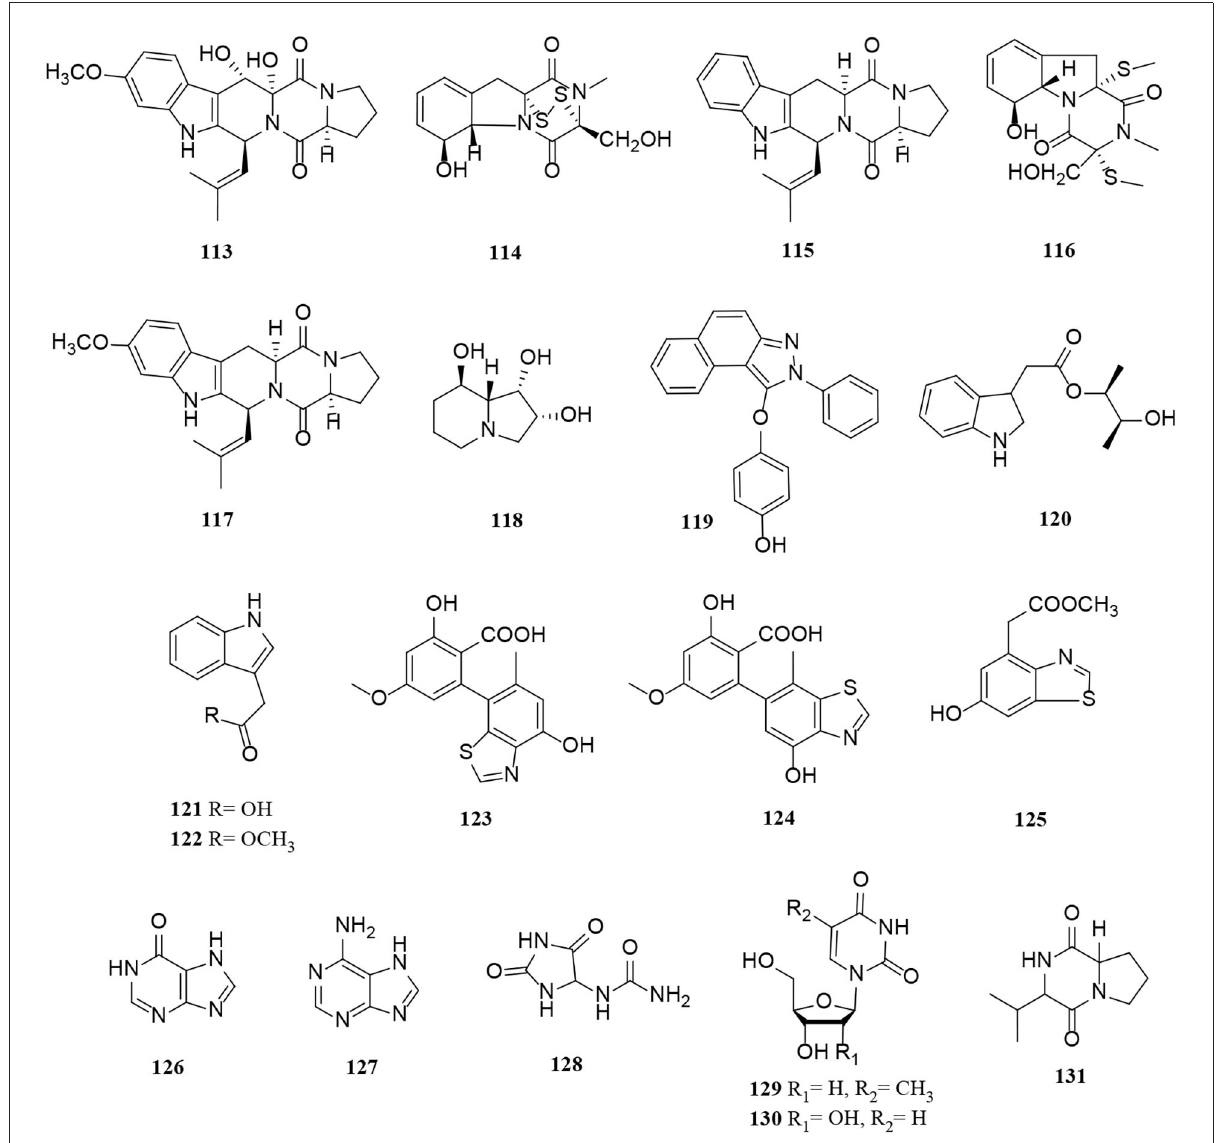
FIGURE7 Peptide and alkaloid derivatives ( 113 – 131 ) from Alternaria